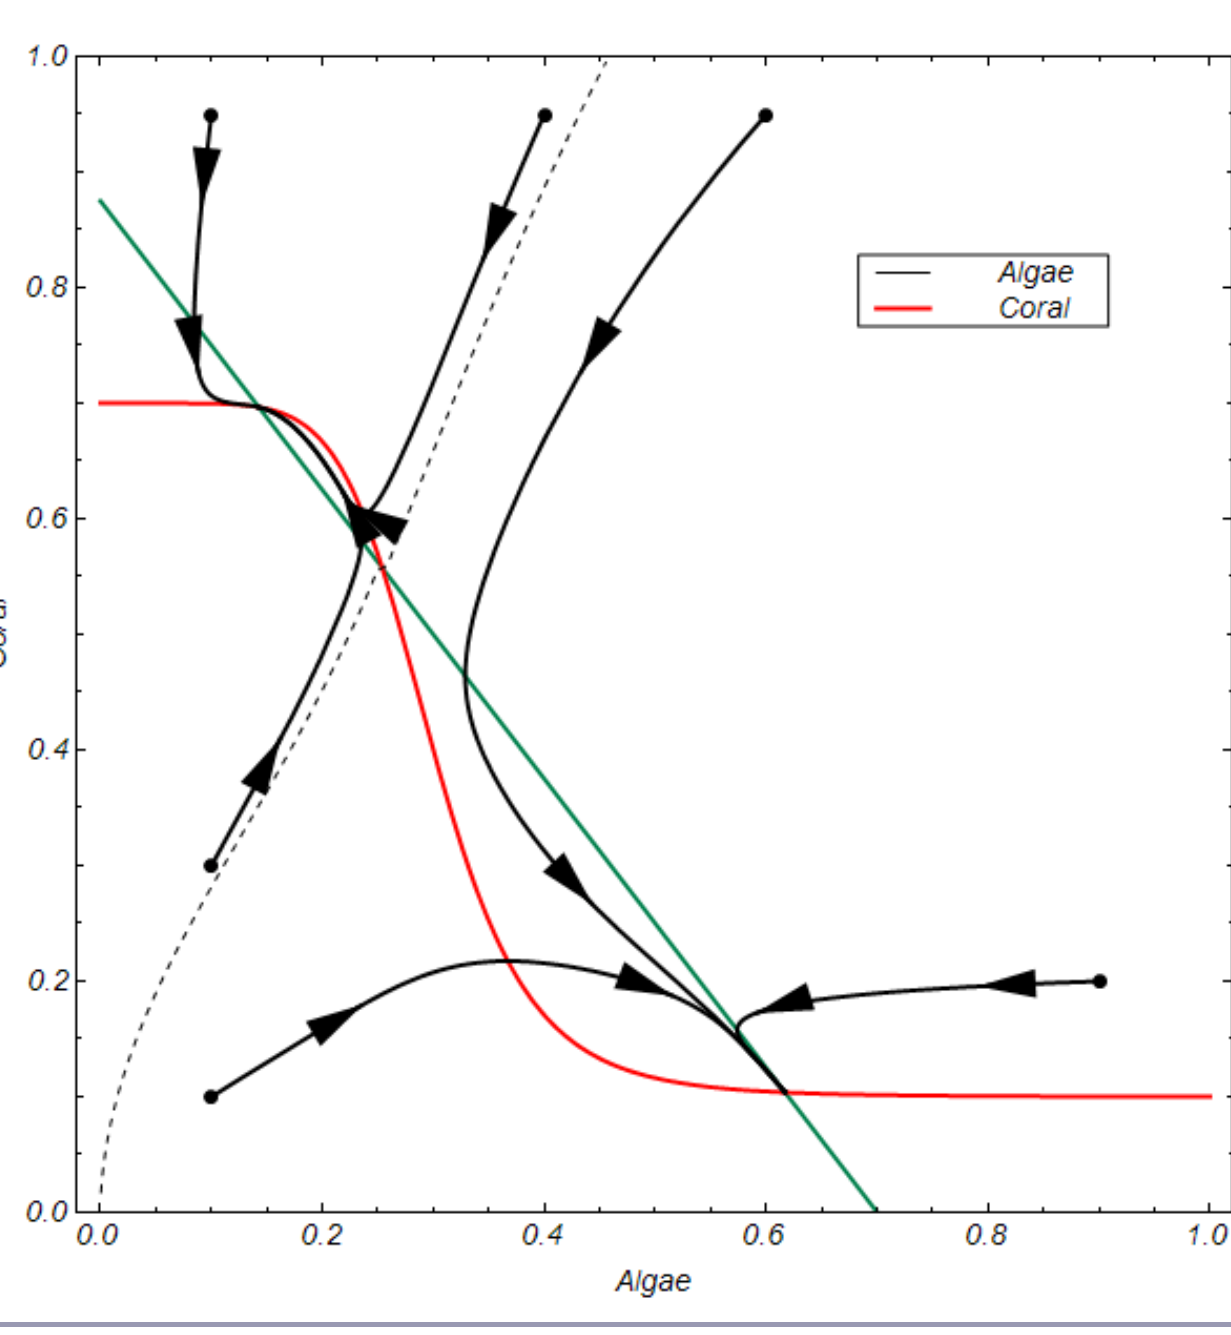
Fig. 1 . Algal and coral nullclines produce alternate stable states. The arrowed lines represent different sample trajectories based on different initial conditions. The dashed line, the separatix, divides the phase plane into two basins of